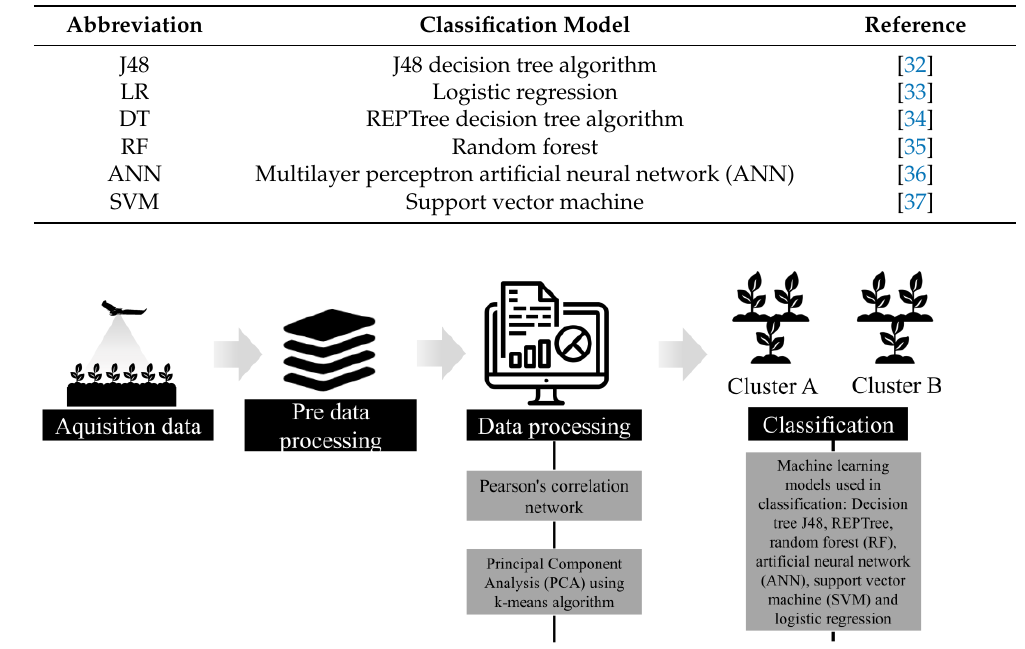
Figure 2. Summary of processes carried out in data analysis.